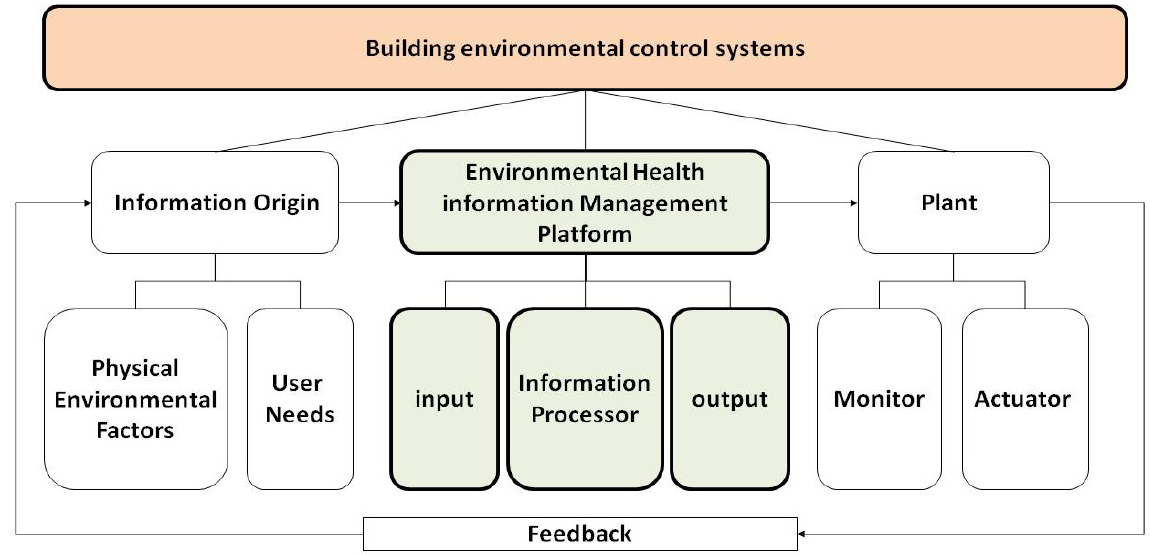
Figure 6. Building environmental control system.